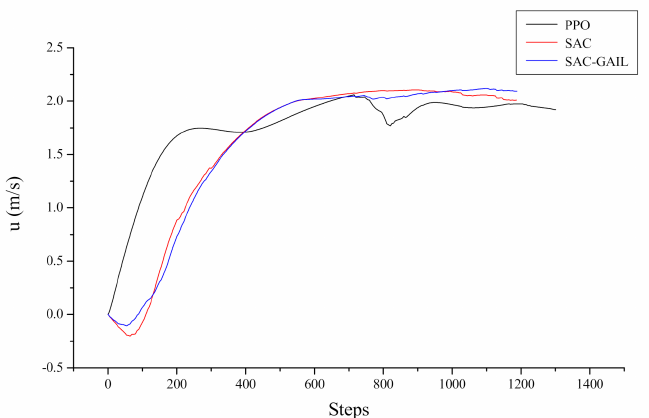
Figure 14. Curve of surge velocity.